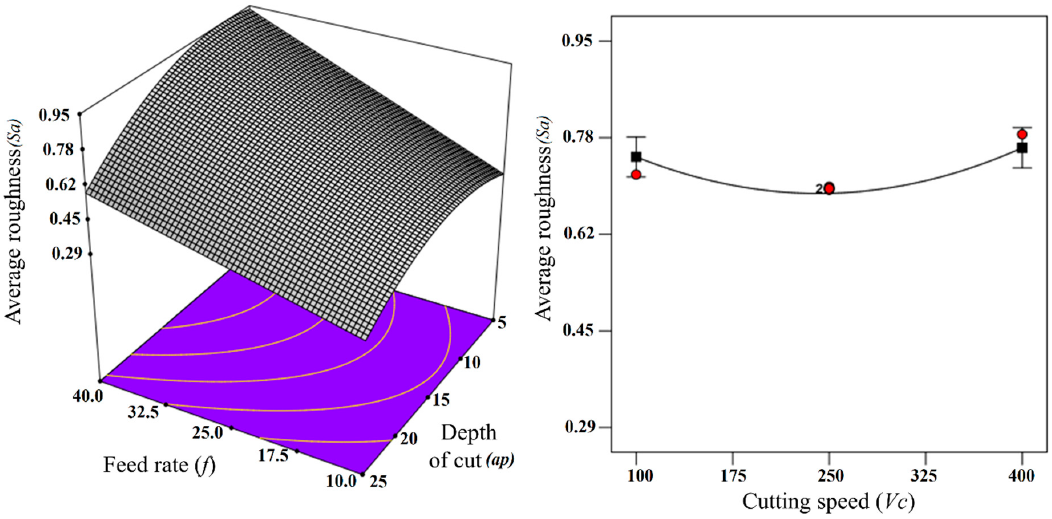
Figure 9. Average surface roughness with 3D plot and one factor plot.